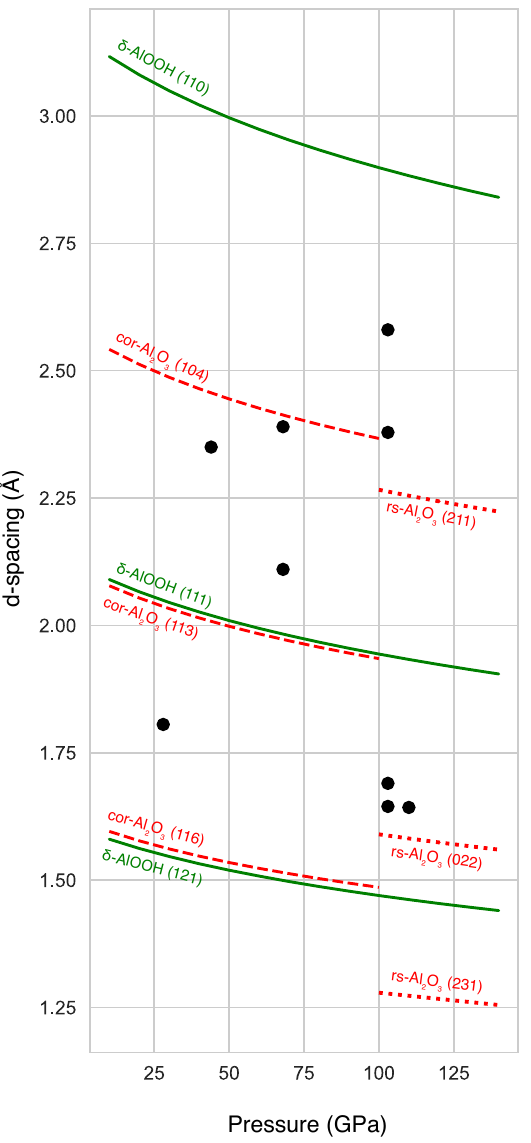
Figure A3. d spacing of unknown peaks observed in experimental runs as a function of pressure (black symbols). For reference, d spacing of δ -AlOOH, cor-Al 2 O 3 and rs-Al 2 O 3 for three different peaks are shown as